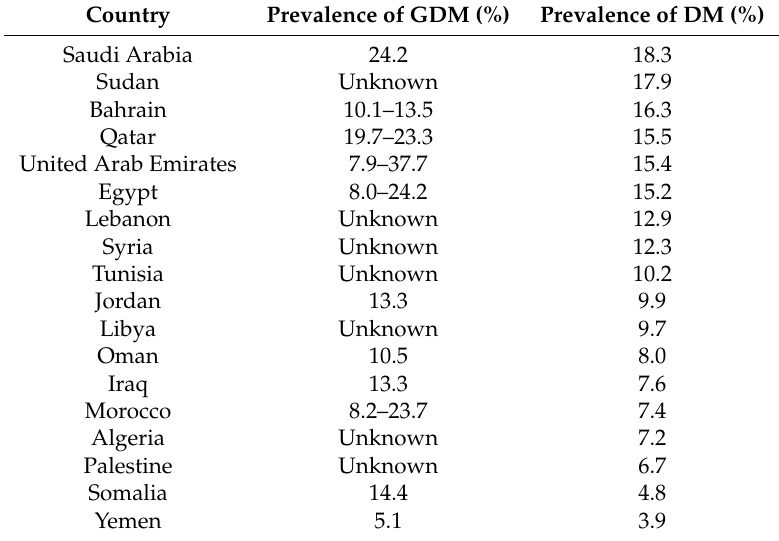
Table 2. Prevalence of type 2 diabetes mellitus (T2DM) and GDM sorted by the prevalence of diabetes mellitus